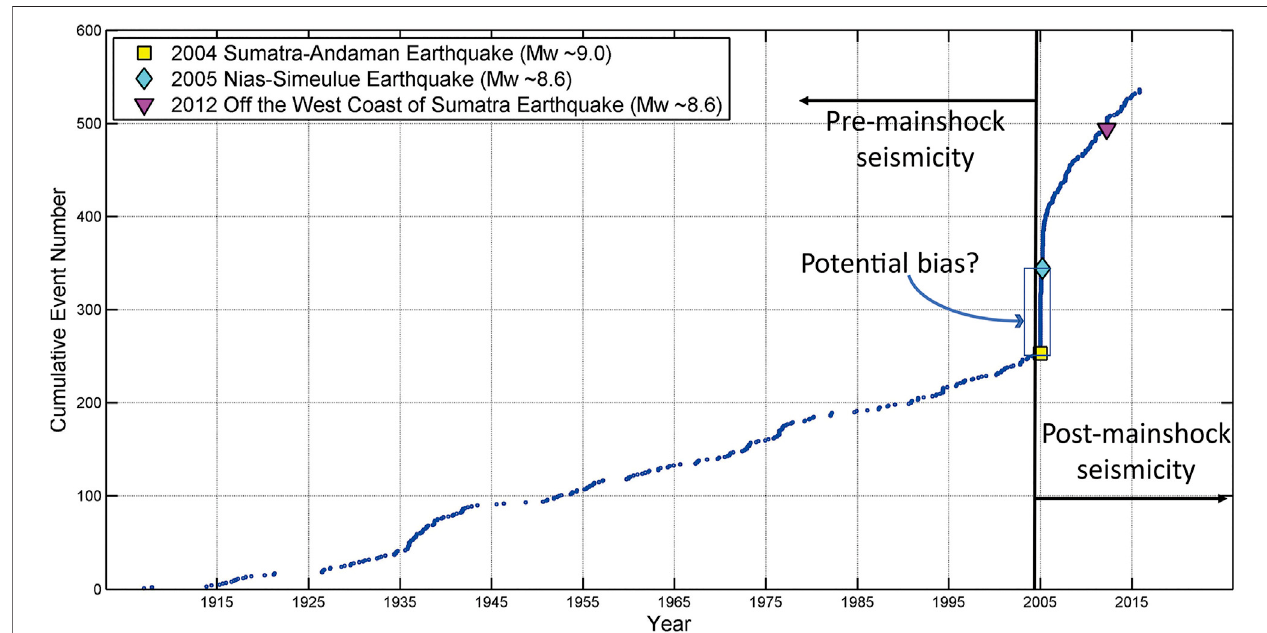
FIGURE 2 | Cumulative seismicity during the years 1907 – 2015, for earthquakes near the Sumatran subduction zone, based on data from the ISC-GEM (Storchak et al., 2015) catalogue. Also indicated are the points on the curve where the 2004 Sumatra-Andaman, 2005 Nias-Simeulue and 2012 Off-west Sumatra earthquakes occurred. The minimum magnitude of the earthquake catalogue in Figure 2 is 5.0. Following Triyoso et al. (2020), the magnitude completeness ( M c ) in Sumatra subduction is also 5.0. Therefore, we are sure that the catalogue completes at this level for the whole period of time. The potential bias in the fi gure refers to the aftershocks of the 2004 earthquake that could affect the stress fi eld on the 2005 earthquake rupture zone (or in this case segment C).